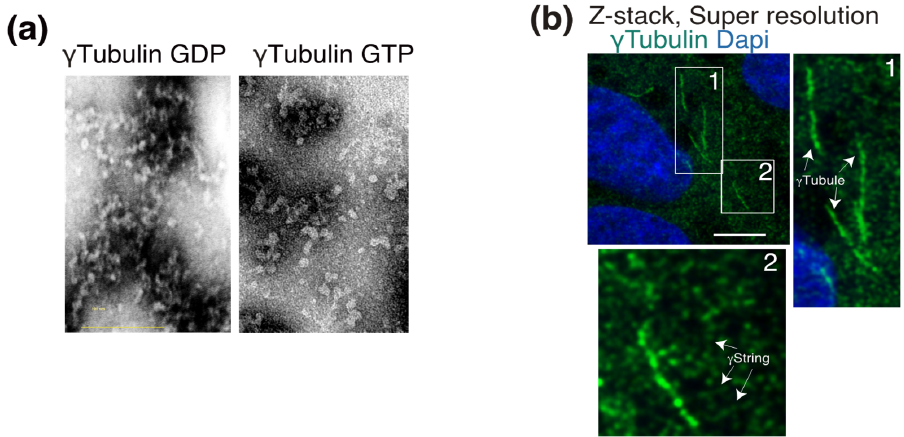
Figure 2. γ-Tubulin is the main constituent of γstrings and γ-tubules. ( a ) Purified γ-tubulin was negatively stained and imaged using electron microscopy in the absence or presence of 1 mM GTP, as indicated. ( b ) Endogenous γ-tubulin was detected with an anti-γ-tubulin antibody, and nuclei were detected with DAPI in fixed U2OS cells. Airyscan super-resolution microscopy was performed to capture the faintest signals emitted by thin γstrings and reveal the γ-tubulin meshwork details. Z-stack shows average intensity projection of 14 sequential Airyscan super-resolution images that were collected at 0.2-μm intervals. The white boxes indicate the magnified area shown in the insets. White arrows indicate γ-tubules and γstrings, as indicated. Scale bars: 10 μm. ( a and b ) These data are from unpublished works by Alvarado-Kristensson et al.